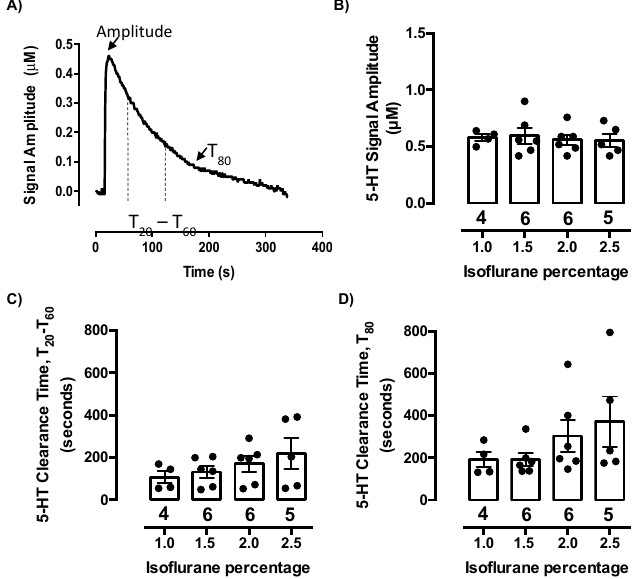
Figure 1. Isoflurane does not impact serotonin clearance at low concentrations. ( A ) Representative trace with signal parameters defined; ( B ) Serotonin signal amplitude did not change as a function of isoflurane percentage; ( C ) Serotonin clearance time (T 20 -T 60 ) and ( D ) (T 80 ) in seconds at varying concentrations of isoflurane (1.0–2.5%). There was no statistically significant difference in serotonin clearance time among the isoflurane concentrations. Circles represent individual mice. Data are mean ± S.E.M.